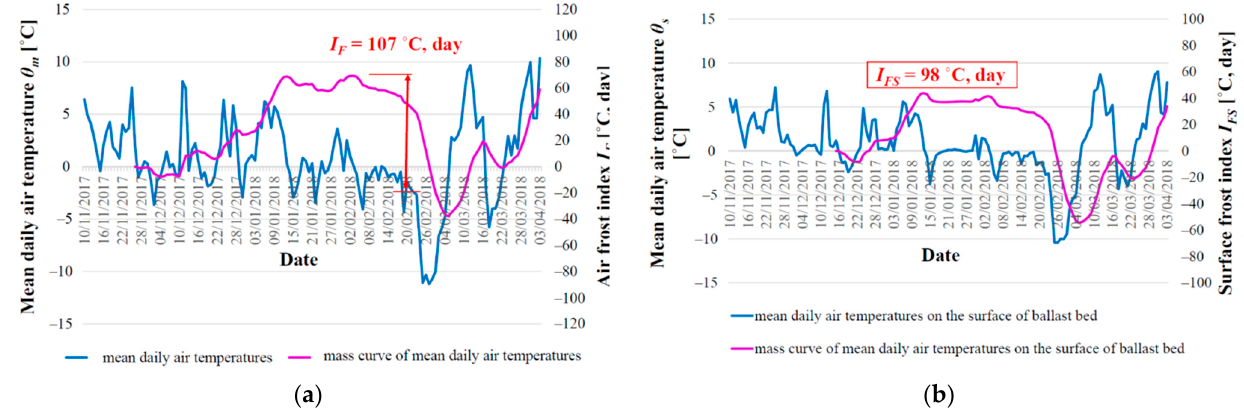
Figure 5. Graphical representation and method of evaluation of climate characteristics of the winter period 2017/2018 by air freezing index ( a ); surface air freezing index ( b ).